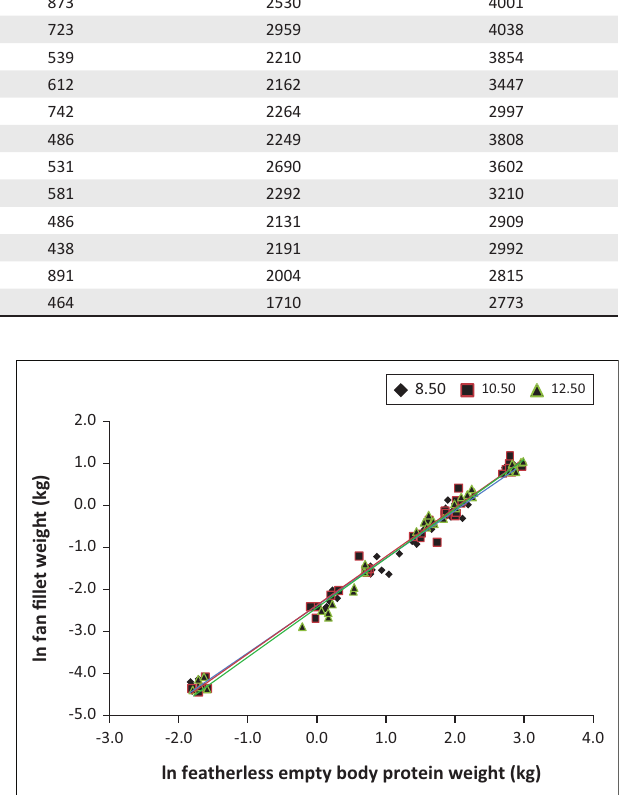
FIGURE 1: Regression lines fitted to the natural logarithms of the M. iliofibularis (fan fillet) weights (kg) against the natural logarithms of the empty body protein weight (kg) for the different dietary energy levels (8.5, 10.5 and 12.5 MJ